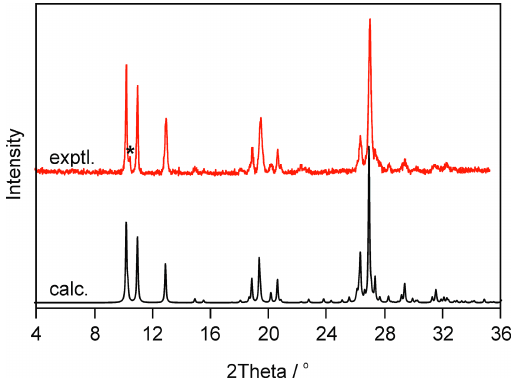
Figure 11. Experimental 2-I PXRD pattern obtained at RT compared with the simulated RT pattern for the calculated structure 1_745. Asterisk ‘*’ indicates a 2-Hy1 phase impurity.